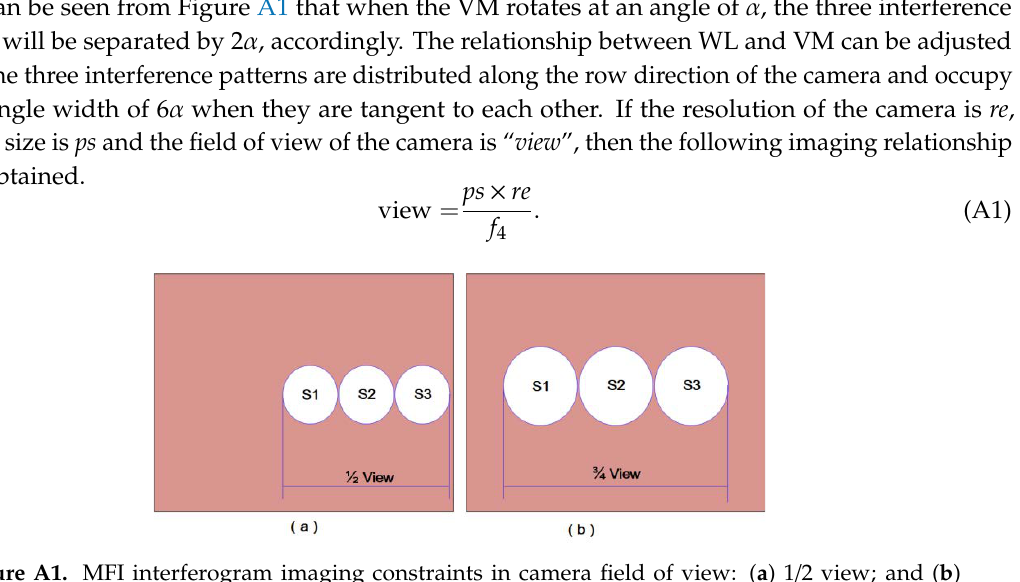
Figure A1. MFI interferogram imaging constraints in camera field of view: ( a ) 1/2 view; and ( b ) 3/4 view.